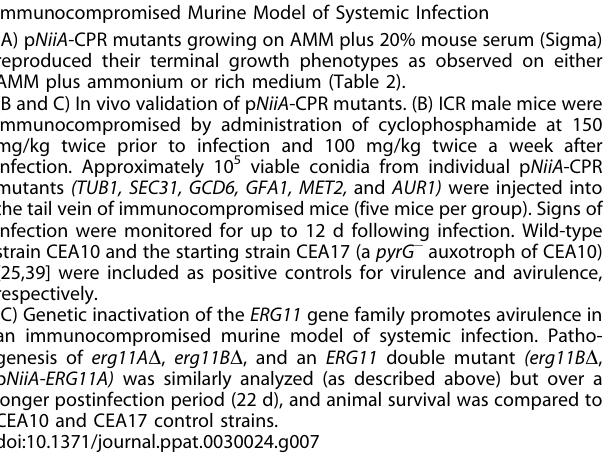
serum (Figure 7A). In each case, TUB1, SEC31, GCD6, GFA1, MET2, AUR1, and p NiiA - ERG11A, erg11B D CPR mutants